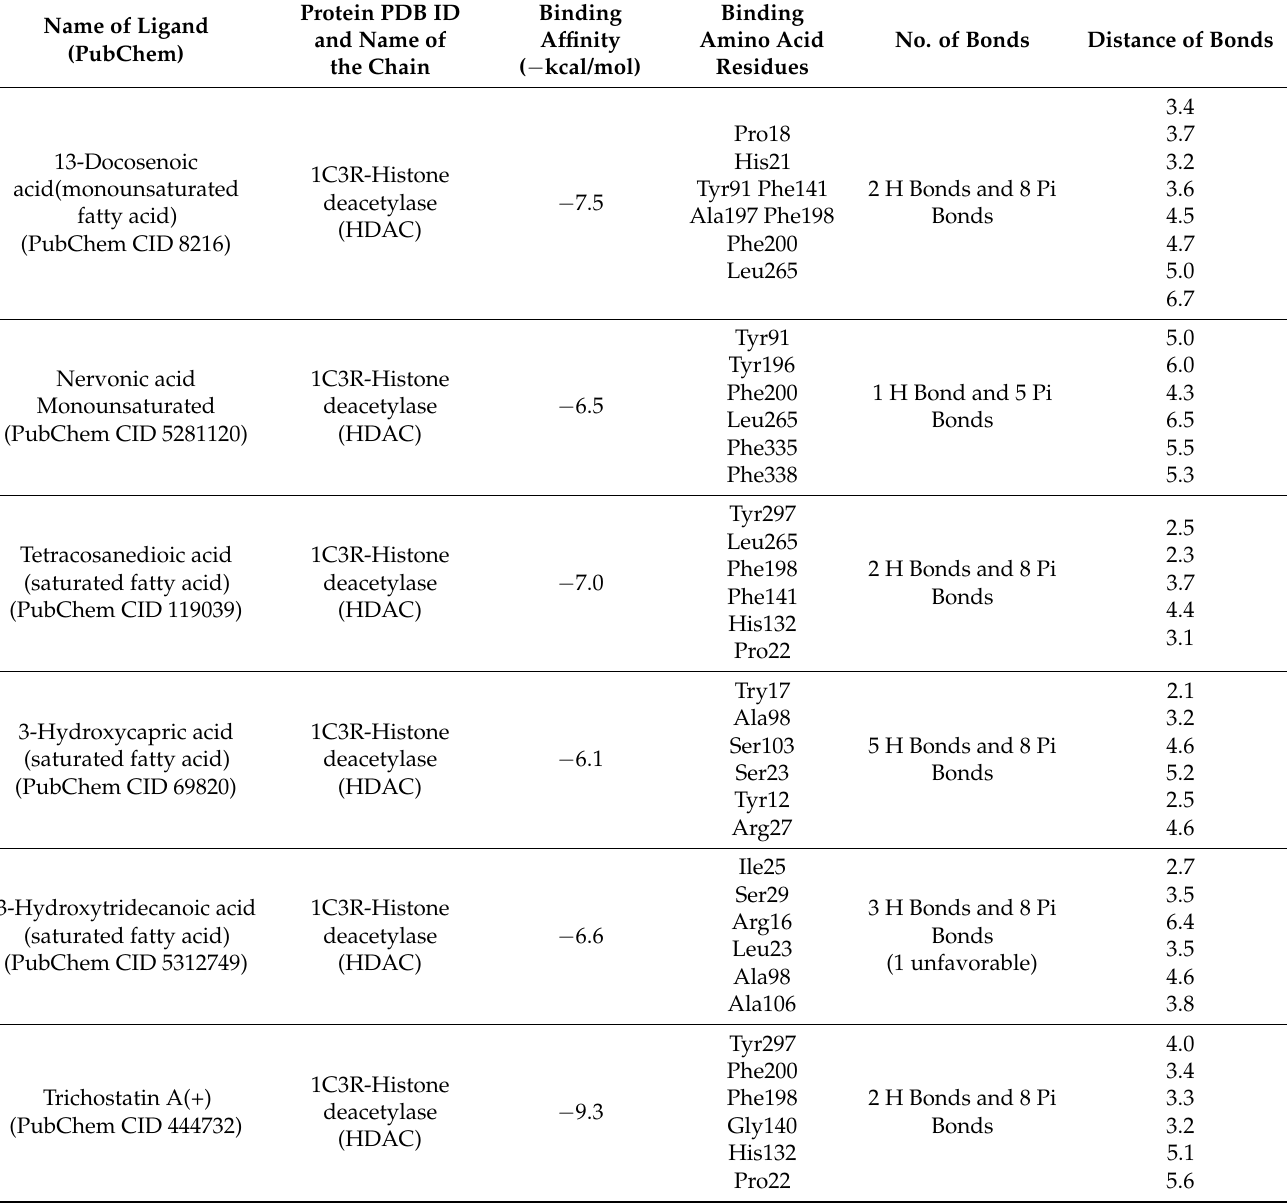
Table 2. Molecular interactions of intracellular free fatty acids with histone deacetylase (PDB ID 1C3R) show specific binding within the inhibitory sites of enzymes. Binding amino acid residues and the nature of bonds were visualized using DSV-3 on AutoDock Vina docked output